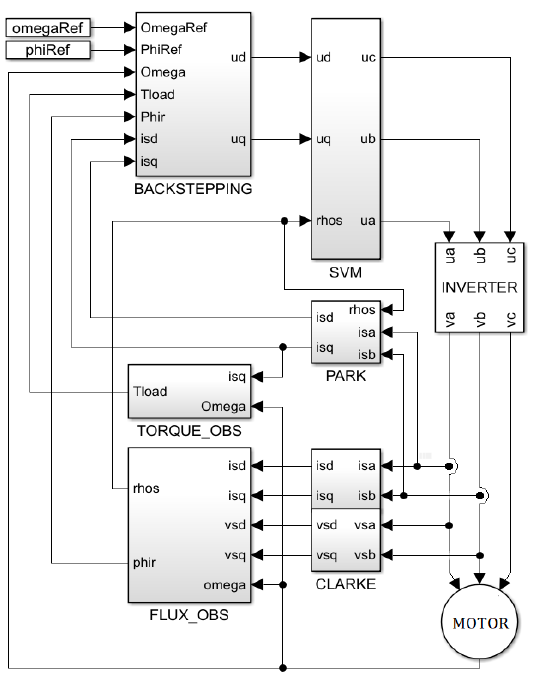
Fig. 1. Synoptic diagram of Backstepping